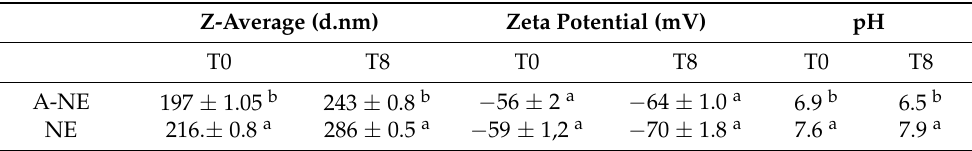
Table 6. Mean droplet diameter (Z-average), zeta potential (ZP), and pH values of preliminary stability tests of nanoemulsions containing phenolic-enriched A. unedo extract (A-NE) and blank nanoemulsion